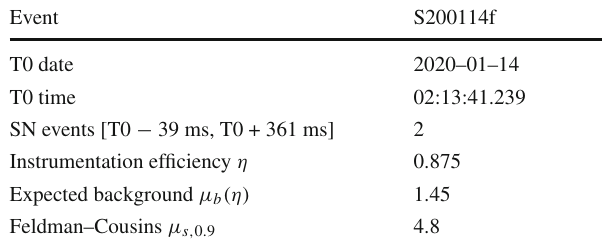
Table 2 Lower limits on the CCSN distance at the 90% confidence level ( d 0 . 9 ) from the follow-up of S200114f for the three progenitors considered in Ref. [14]